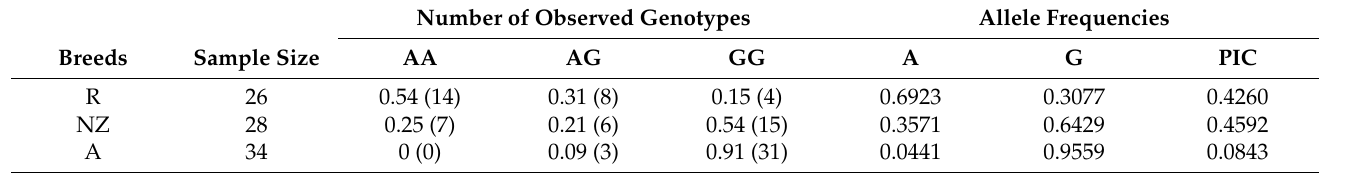
Table 1. Genotype distribution and allele frequencies of the SNP in P6 of the WIF1 gene in the three rabbit